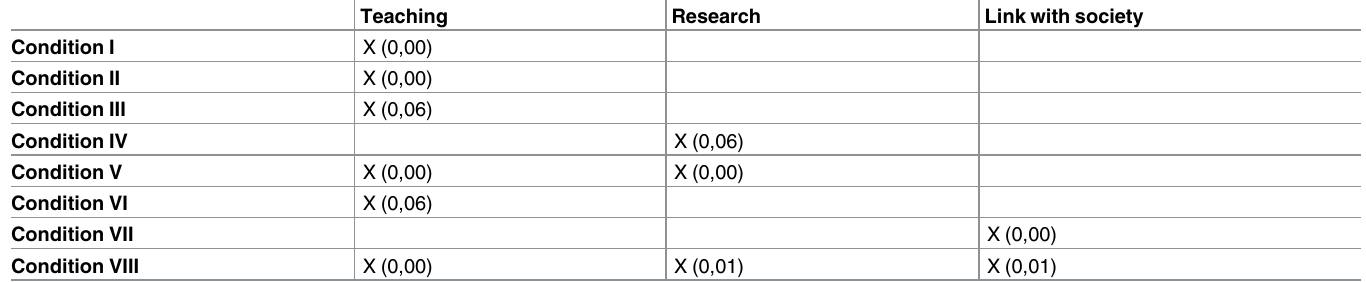
Table 6. Conditions imposed by SUNEDU in which the relationship with the characteristics of the researchuniversity is high or very high. The RIR of the responses is shown in